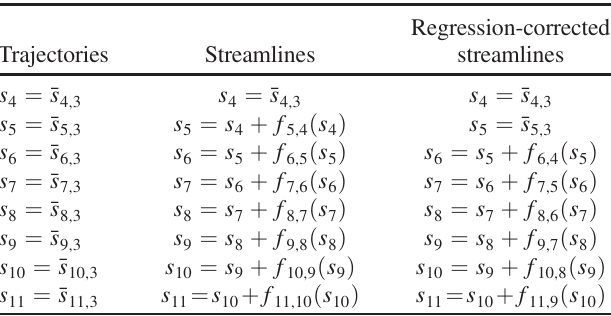
TABLE IV. Comparison between the observed/computed score sequences within the trajectory, cohort streamline, and RC cohort streamline frameworks. These are the values that are used when creating the plots.